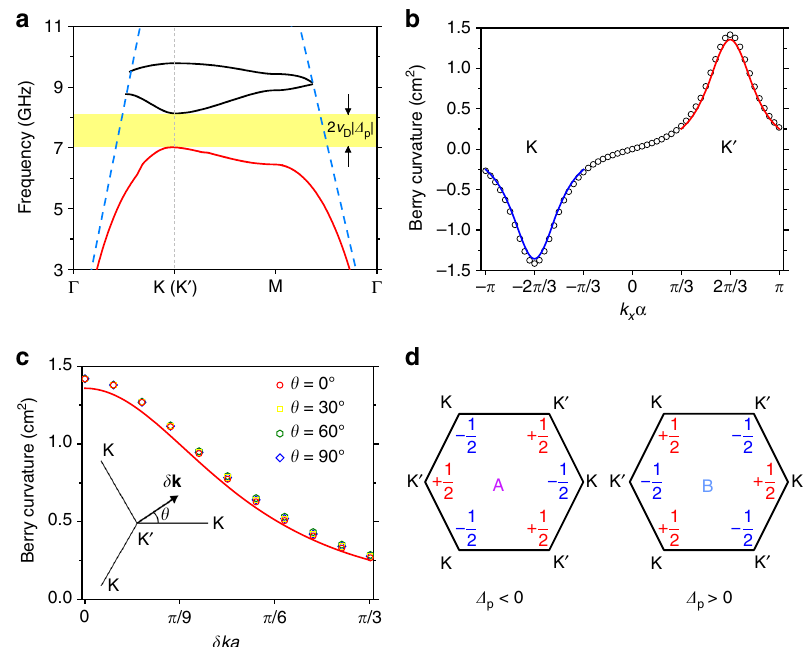
Fig. 2 Band structure of the DSP crystal with breaking of Γ K-mirror symmetry and topological property of its fi rst band. a Calculated band structure of the DSP crystal along the special directions of the FBZ when Δ R = ± 0.5 mm (pattern A or B). Blue dashed lines represent the light line and only the guided part of the band structure is shown. The light yellow shaded region represents the full bandgap. b Berry curvature of the fi rst band for pattern A along the line ffiffiffi p (cid:3) (cid:4) k y ¼ 2 π = a 3 in the reciprocal space from numerical calculations (open circles) and effective Hamiltonian model near the K (blue solid line) or K ′ (red solid line) valley. c Berry curvature for pattern A around a K ′ valley as a function of δ k for different polar angles θ (open symbols). The red solid line represents the isotropic result from the effective Hamiltonian model. The inset shows the de fi nition of δ k and θ in the reciprocal space. d Valley